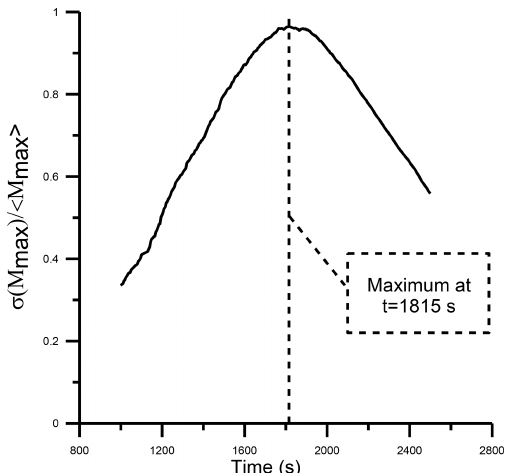
Figure 4. Time evolution of the normalized standard deviation σ(M max )/ (cid:104) M max (cid:105) of the largest droplet mass versus time estimated from the Monte Carlo algorithm. The simulations were performed for the turbulent hydrodynamic kernel with a bi-disperse initial con- dition (200 droplets of 10µm in radius and 50 droplets of 12.6µm) in a volume of 1cm 3